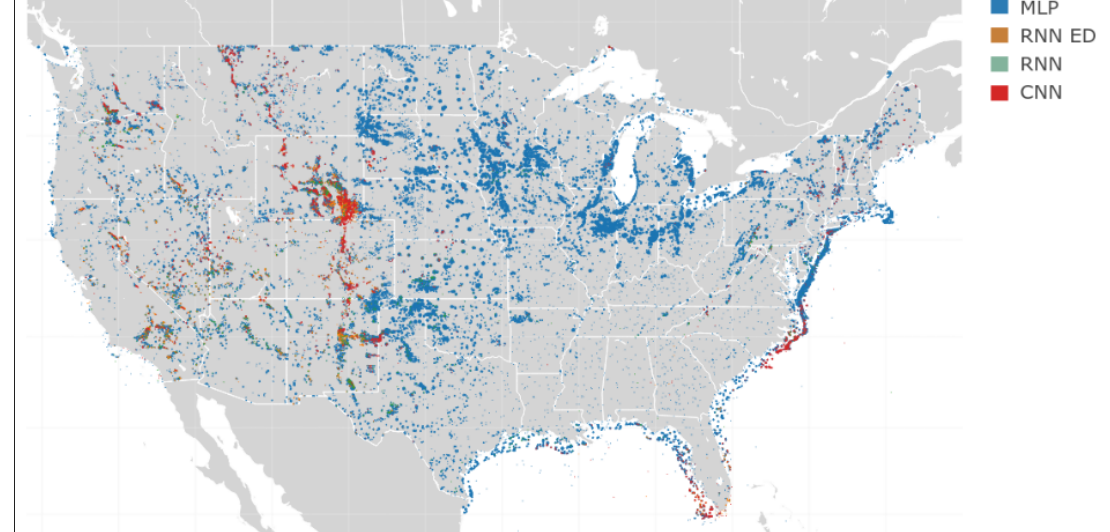
Figure 8. Graphical analysis of the best model for each site. Each site is colored with the best method in that site and shows some geographical wind patterns in the U.S. geography, opening the discussion of the relationship between wind typology and the deep learning